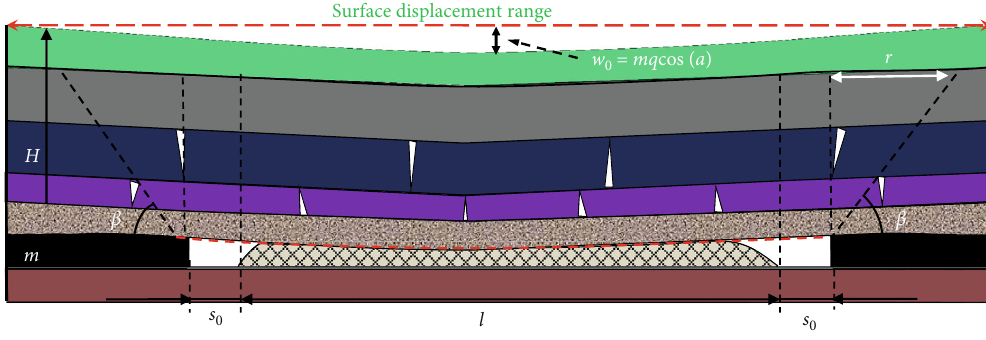
Figure 1: Mining subsidence model diagram.